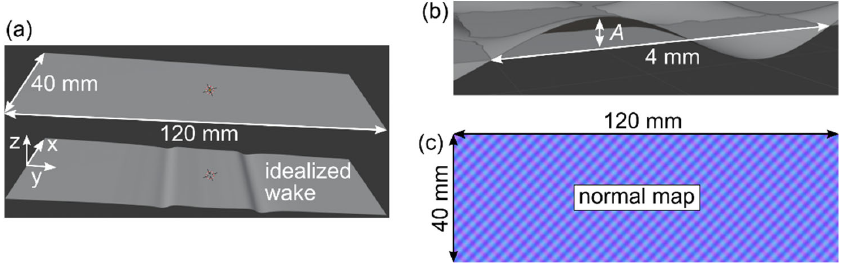
Figure 4. ( a ) Model surfaces in Blender. ( b ) Waviness of the surface and ( c ) normal map of the small surface waves.